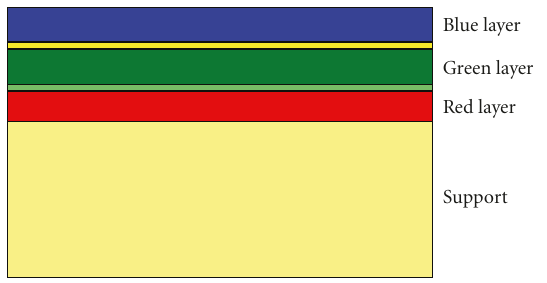
Figure 1: Structure of the color film support.